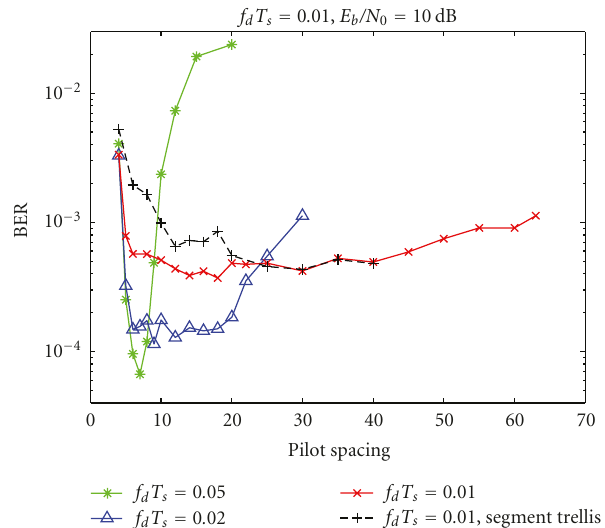
Figure 11: E ff ect of the number of pilot symbols on the perfor- mance of noncoherent detected PA codes on correlated Rayleigh channels with f d T s = 0.01. Code rate 0.75, data block size 1K, filter length 65, 10 (global) iterations, 4 (local) iterations within the outer code of PA codes.